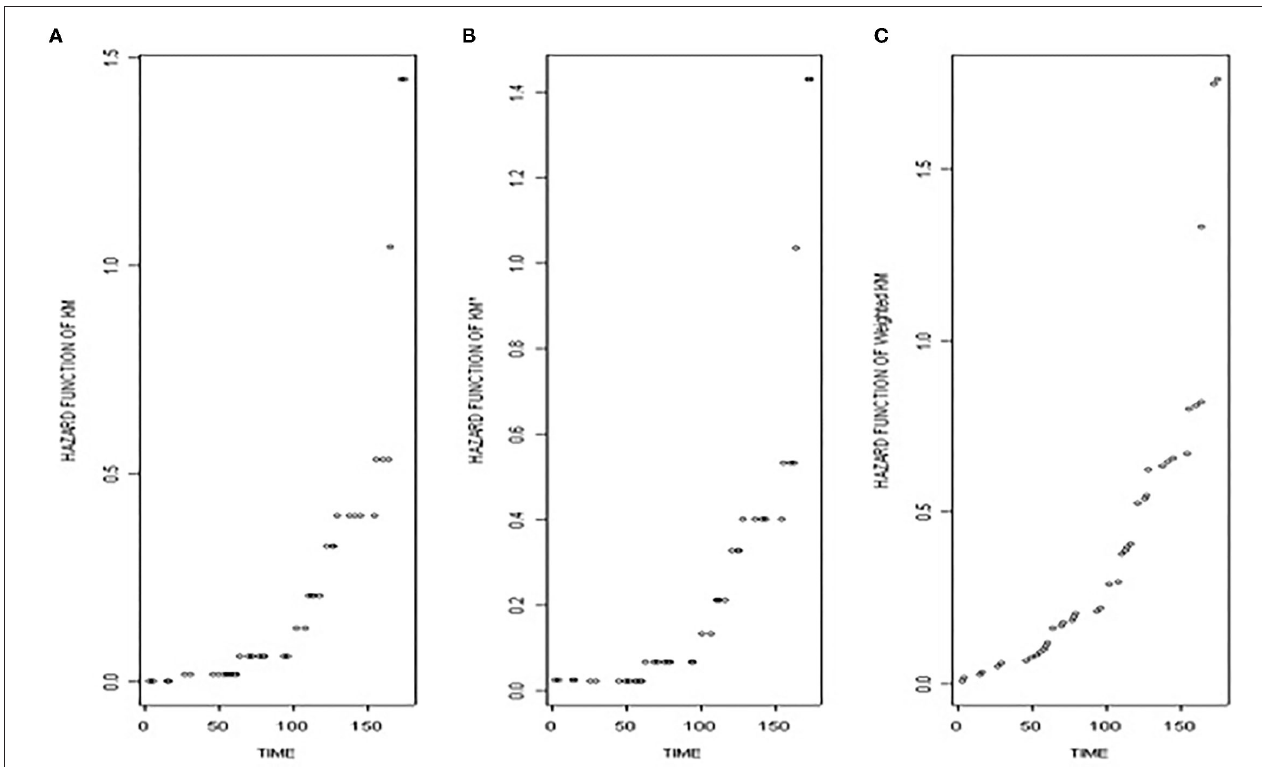
FIGURE 1 | This figure shows the (A) the hazard function based on Kaplan–Meier survival function, (B) the hazard function based on the shrunken Kaplan–Meier survival function, and (C) the hazard function based on the weighted Kaplan–Meier survival function against time.